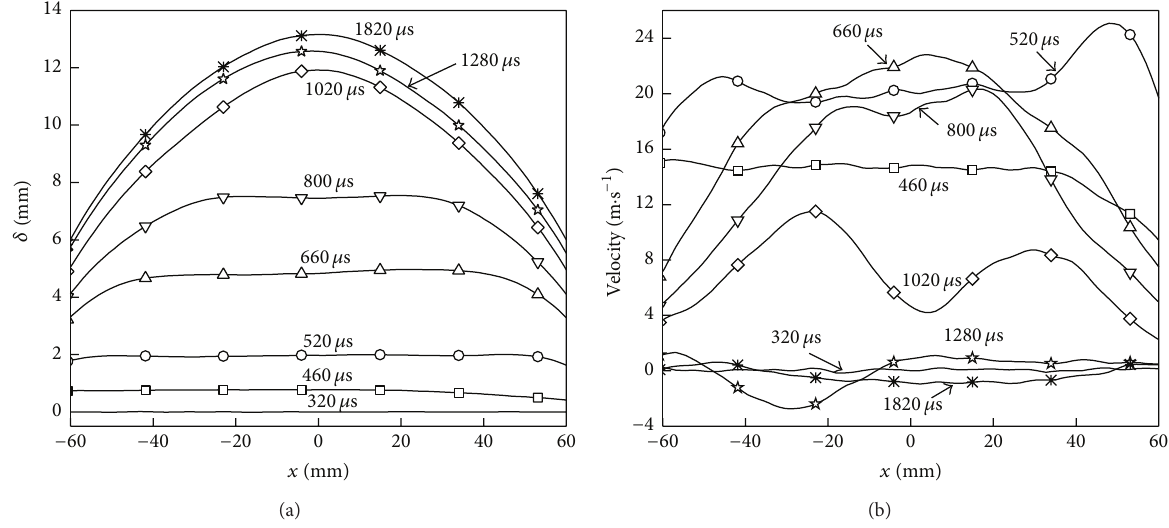
Figure 8: (a) Displacement profile along the 𝑥 -axis; (b) velocity profile along the 𝑥